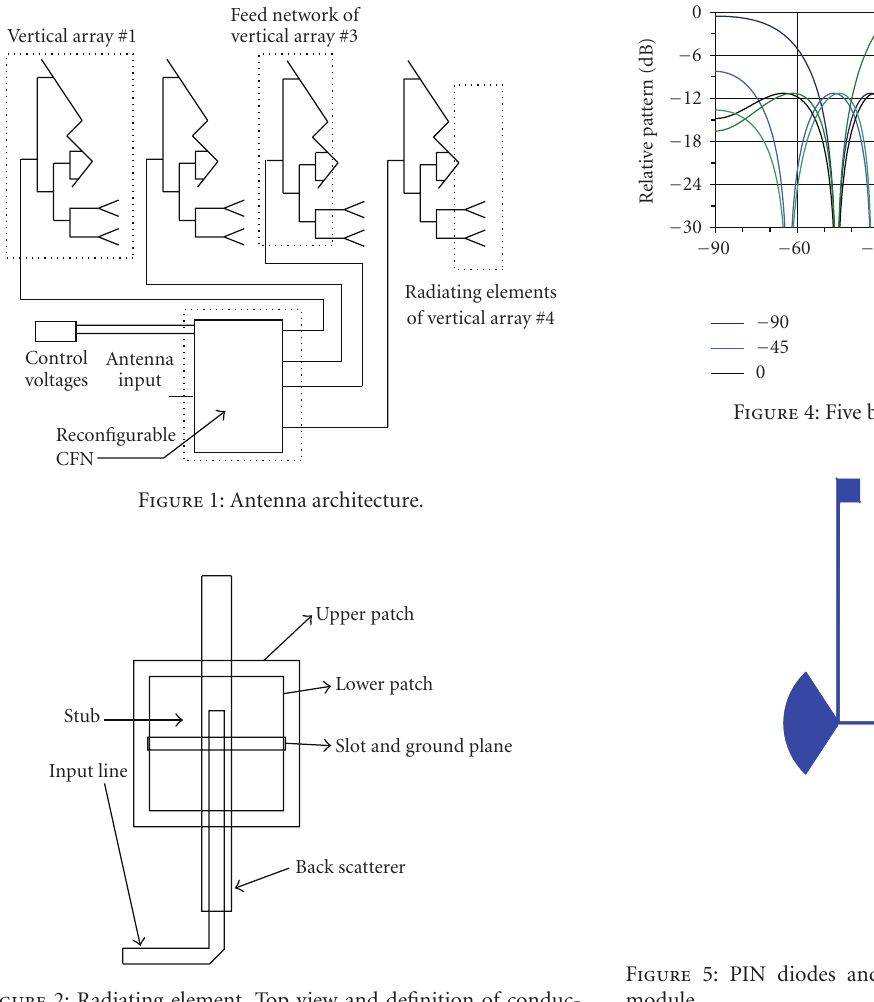
Figure 2: Radiating element. Top view and definition of conduc- tors.